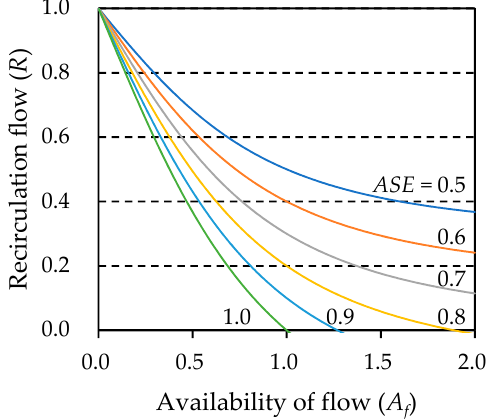
Figure 1. Recirculation flow ( R ) versus availability of flow ( A f ).